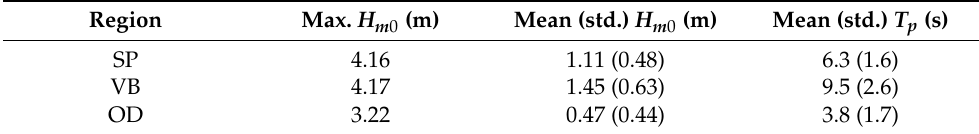
Table 1. Statistics of regional wave climates, including the maximum zero-moment wave height, the mean (and standard deviation) zero-moment wave height, and the mean (and standard deviation) peak